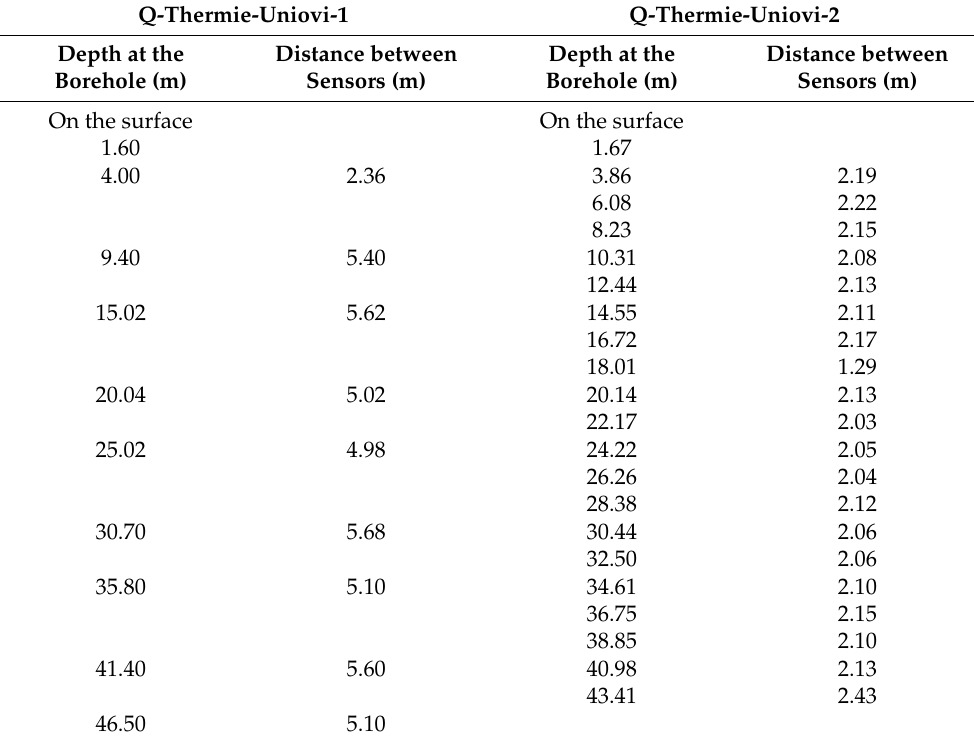
Table 2. DS18B20 sensor depths and distance between sensors in both boreholes. Q-Thermie-Uniovi-1 Depth at